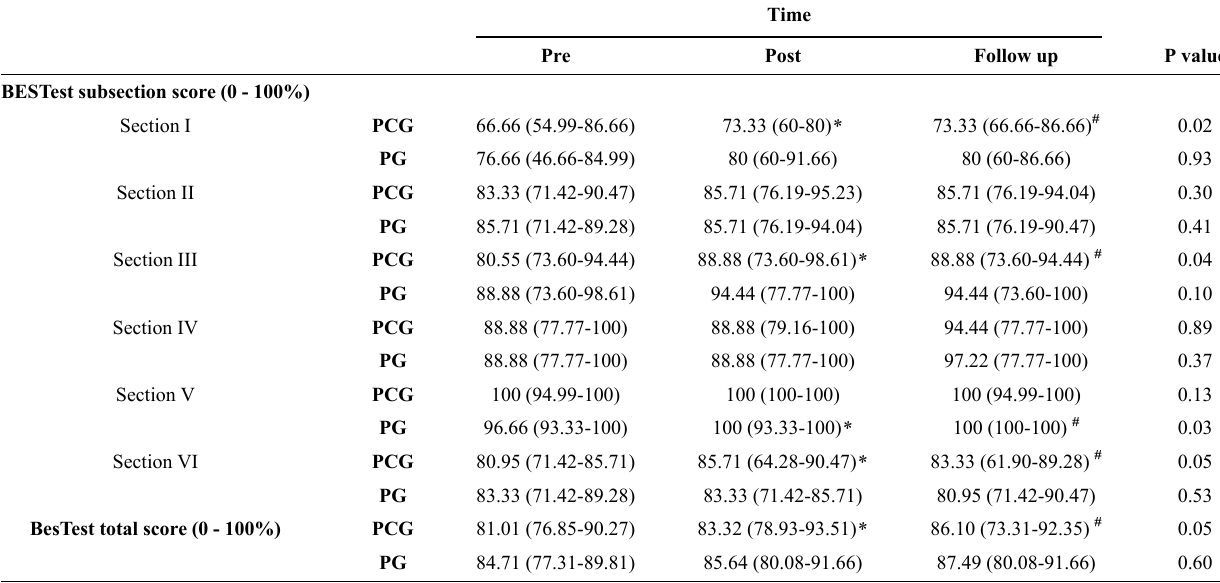
Table 3 - Intragroup comparasion of balance outcome according to